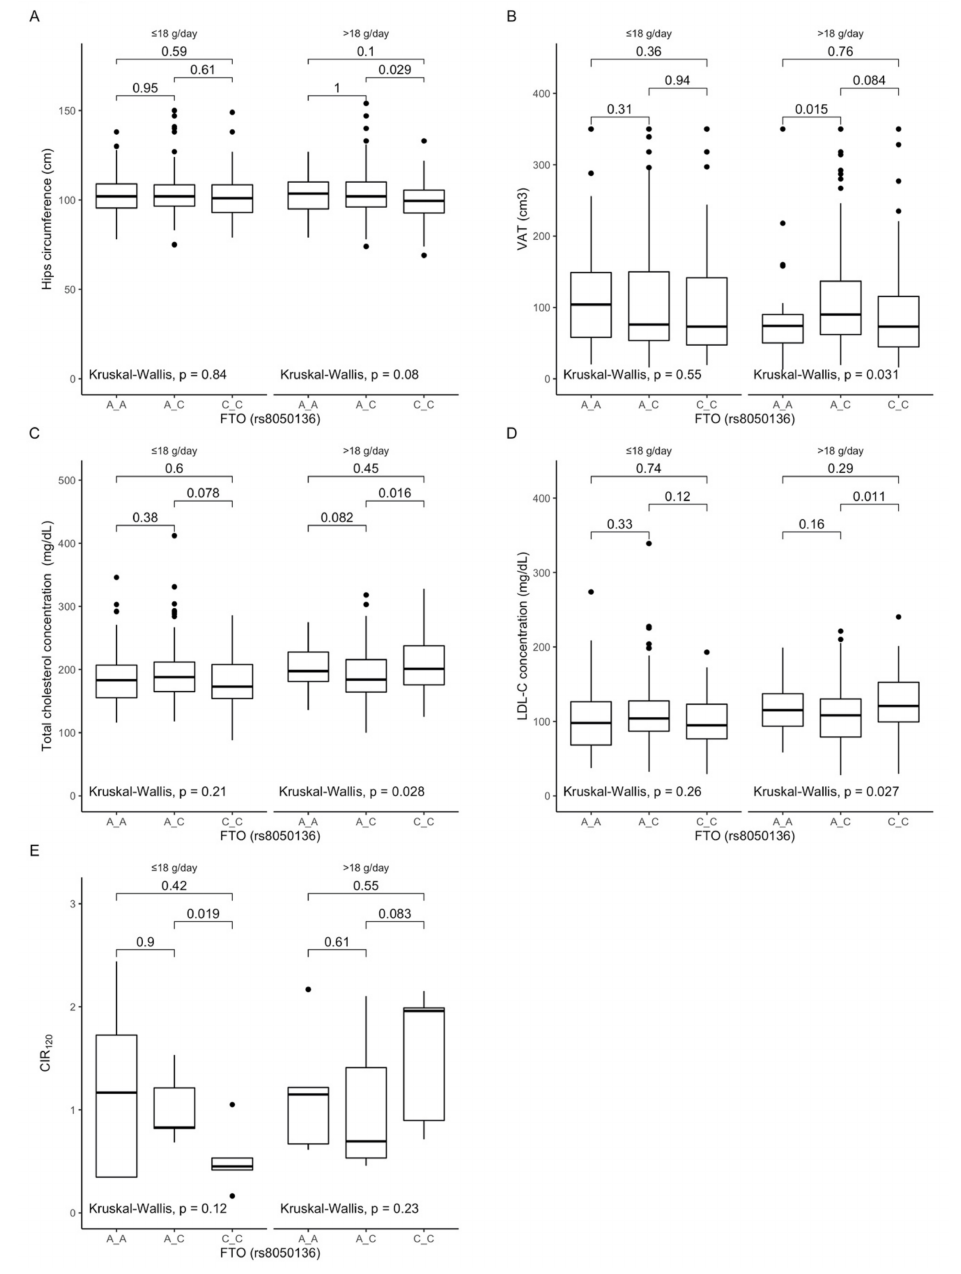
Figure 2. Association of the FTO rs8050136 genotypes with ( A ) Hip circumference (cm); ( B ) Visceral adipose tissue (VAT) (cm 3 ); ( C ) Total cholesterol concentration (mg/dL); ( D ) LDL-C concentration (mg/dL); ( E ) CIR 120 by dietary fiber intake strata: ≤ 18 g/day and >18